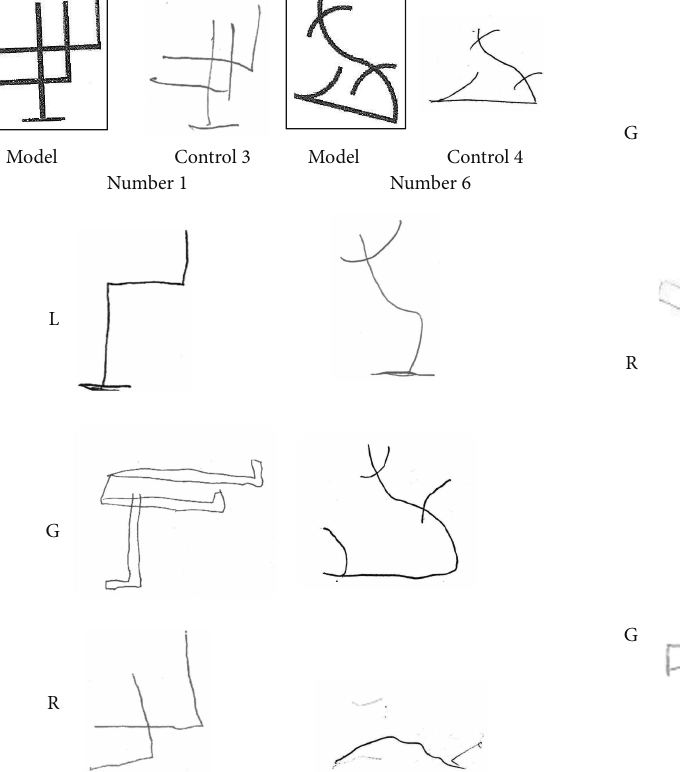
Figure 5: Two examples of immediate visual memory for abstract designs performed by L., G., and R. The model is shown at the top, with the same object recalled by two neurological control subjects on the right. All three children were unable to draw from memory a coherent pattern of a model that did not allow verbal rehearsal strategies.